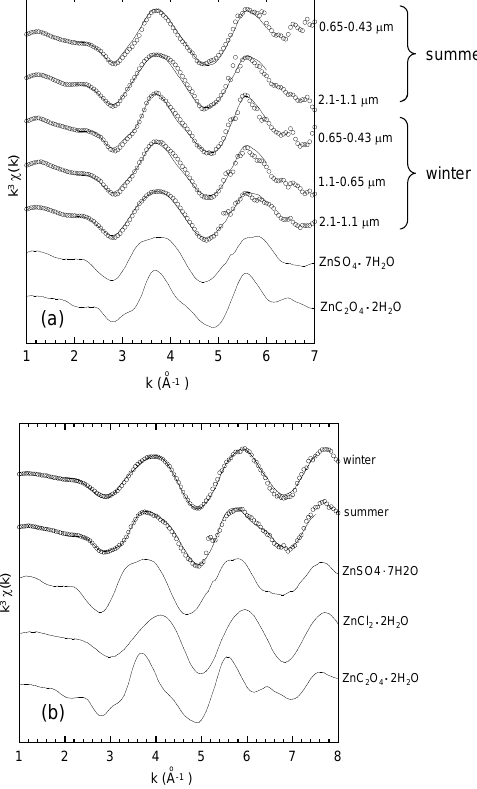
Zinc K-edge EXAFS spectra (open circles=sample, lines=fitting) of finer particles during winter and summer at Tsukuba with standard materials used for fitting: (a) 2.1–1.1,